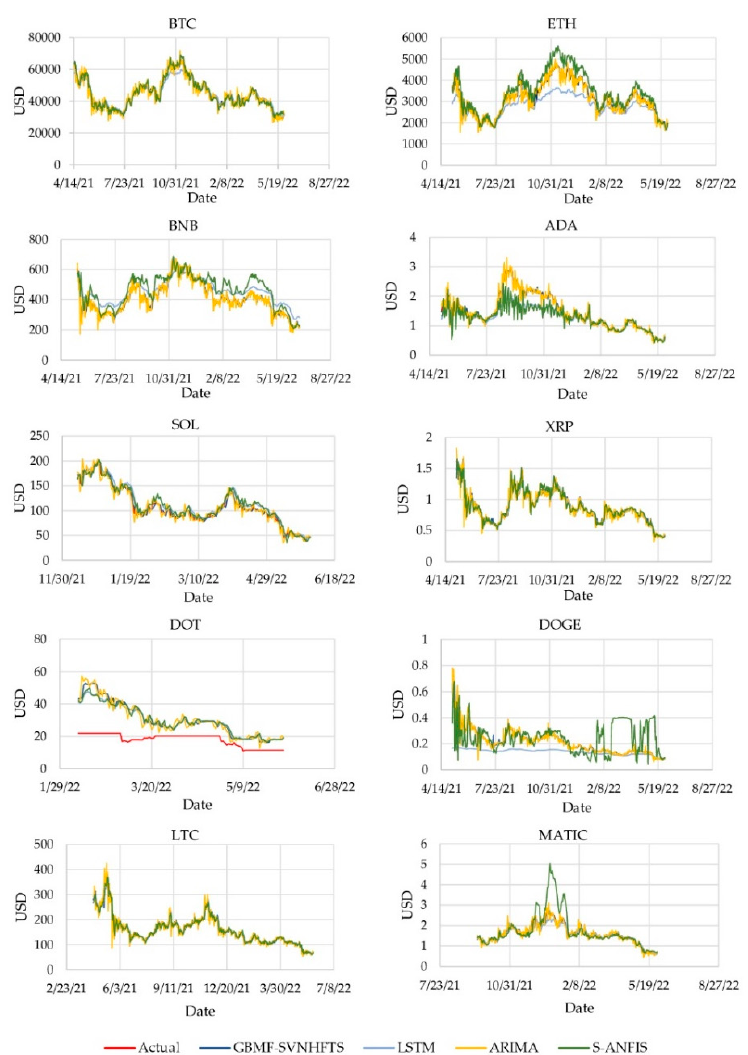
Figure A1. The forecasted values from the testing data of ten major cryptocurrency prices from the GBMF-SVNHFTS and other time series techniques.